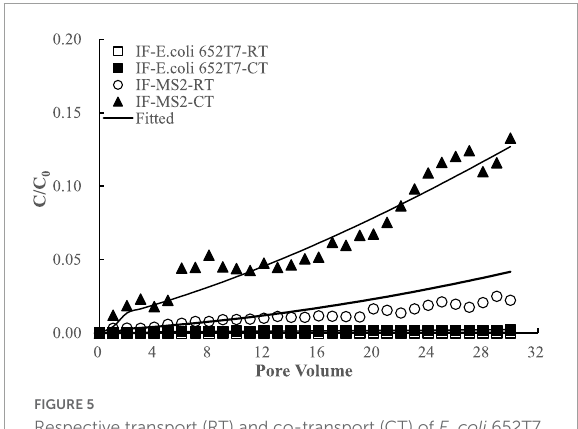
FIGURE5 Respective transport (RT) and co-transport (CT) of E. coli 652T7 in iron filings (IF). The lines are the modeling results with advection-dispersion equation using the Hydrus-1D